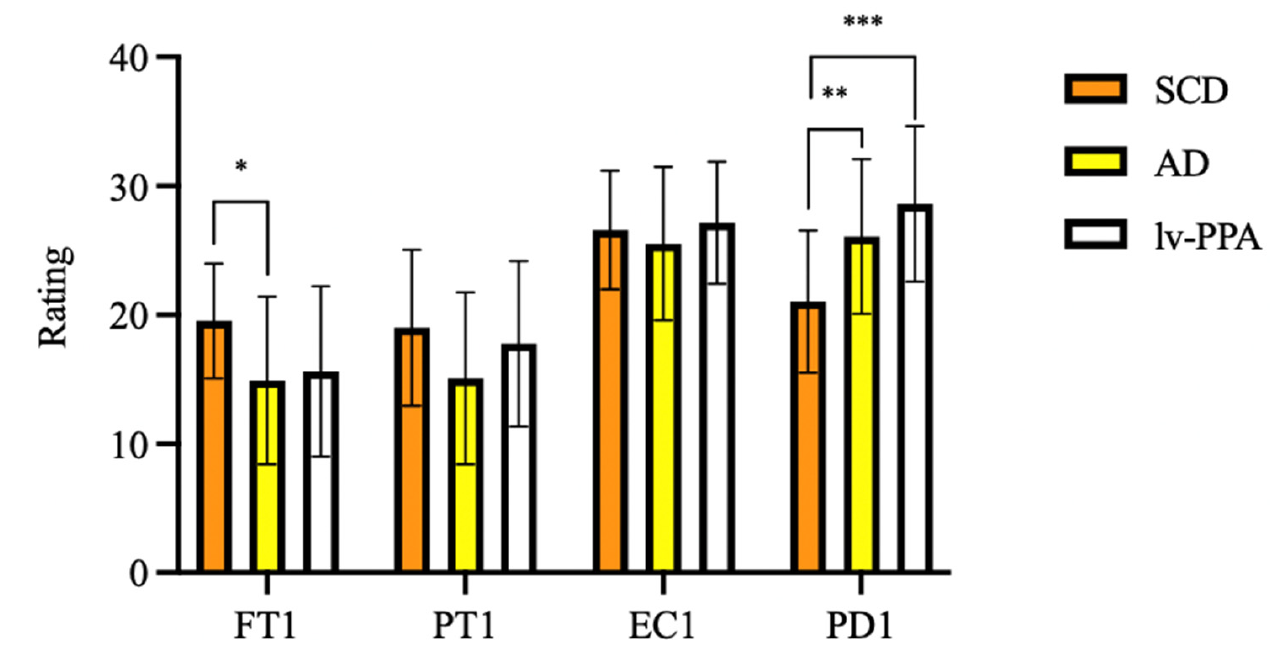
Figure 1. Empathy assessed by Interpersonal Reactivity Index (IRI) in subjective cognitive decline (SCD), Alzheimer’s disease (AD) and logopenic variant primary progressive aphasia (lv-PPA). * p < 0.05, ** p < 0.005, *** p < 0.001. To estimate changes of empathy from before to after the onset of cognitive symptoms in amnesic AD and lv-PPA, Wilcoxon signed-rank test was used (Table 2). A significant decrease of FT (17.11 ± 5.09 vs. 15.05 ± 6.21, z = − 2.464, p = 0.014) was detected in amnesic AD subgroup. A decrease in PT scores was found both in amnesic AD (21.08 ± 6.15 vs. 15.42 ± 6.66, z = − 4.753, p < 0.001) and in lv-PPA patients (23.94 ± 6.40 vs. 15.82 ±